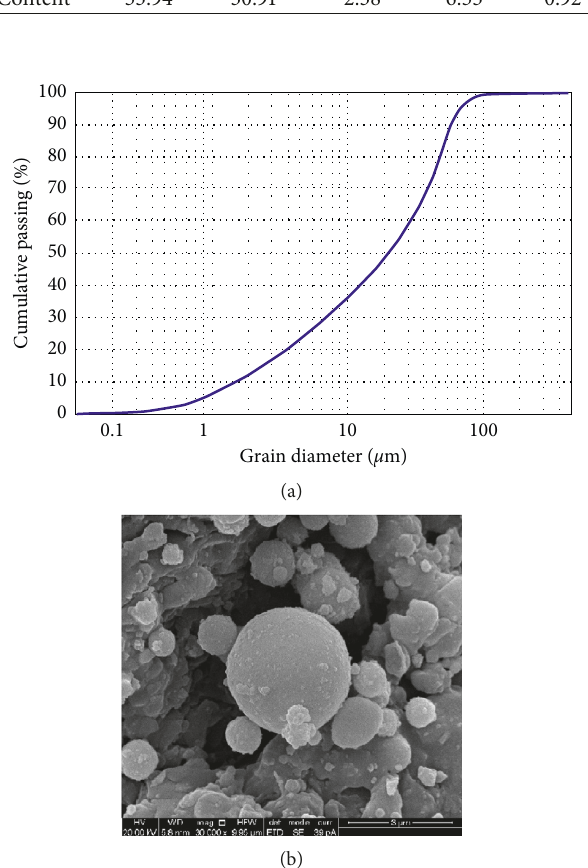
Figure 1: Particle size distribution of fly ash (a) and SEM image (b).